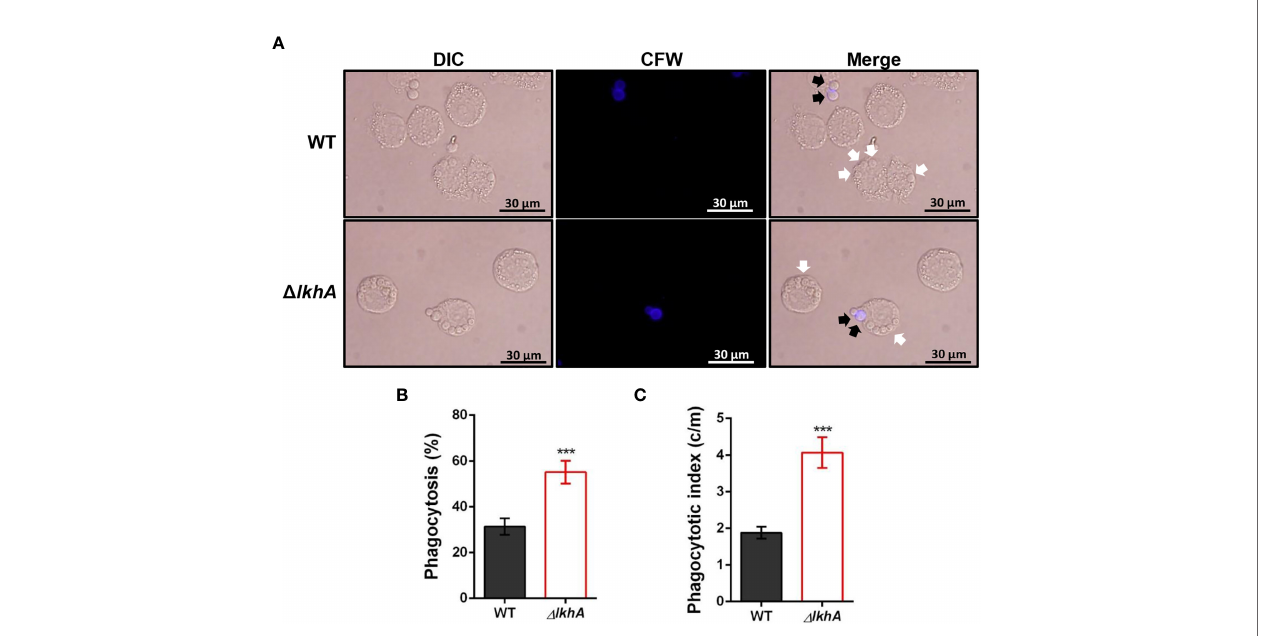
FIGURE 5 | Alveolar macrophage response to D A fl khA conidia. MH-S murine alveolar macrophages were challenged with a three-fold concentration of WTand D A fl khA conidia and then incubated for 4 hrs at 37°C inan atmosphere of 5% CO 2 . (A) Microscopicanalysisof the uptakeof the fungal conidiaby MH-S macrophages. External conidia (blackarrows) were stained bycalco fl uor white (1 m g/mL inDPBS). White arrows indicateconidia endocytosed by macrophage cells. (B) Phagocytosisofconidia. The percentage of macrophages containing more than one ingestedconidiawas counted (n= 18). (C) Phagocytosis index. The average number of indigested conidia per macrophage (c/m)was calculated (n= 40).Statistical analysiswas performedusing the student ’ s t-test. ***P < 0.001.